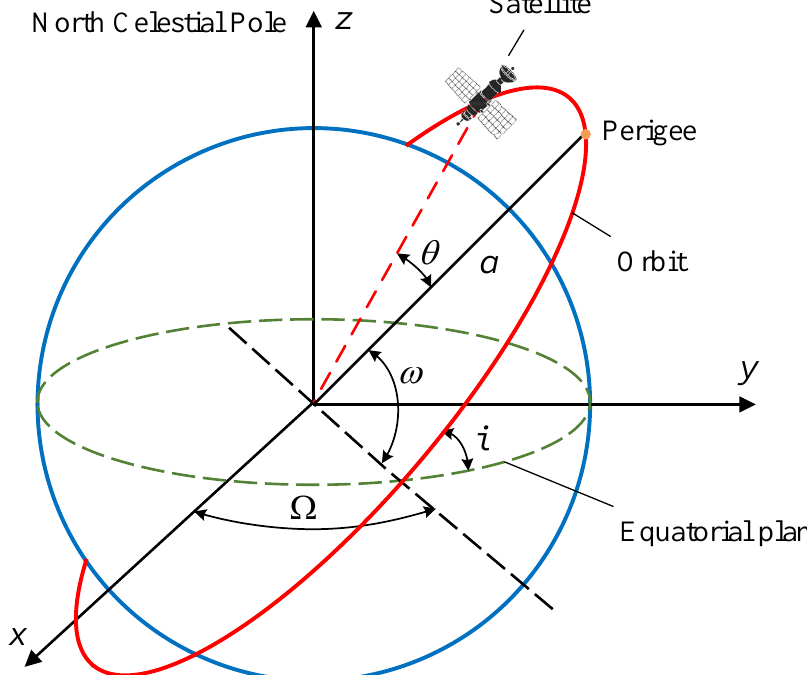
Figure 2. Geocentric equatorial frame and the orbital